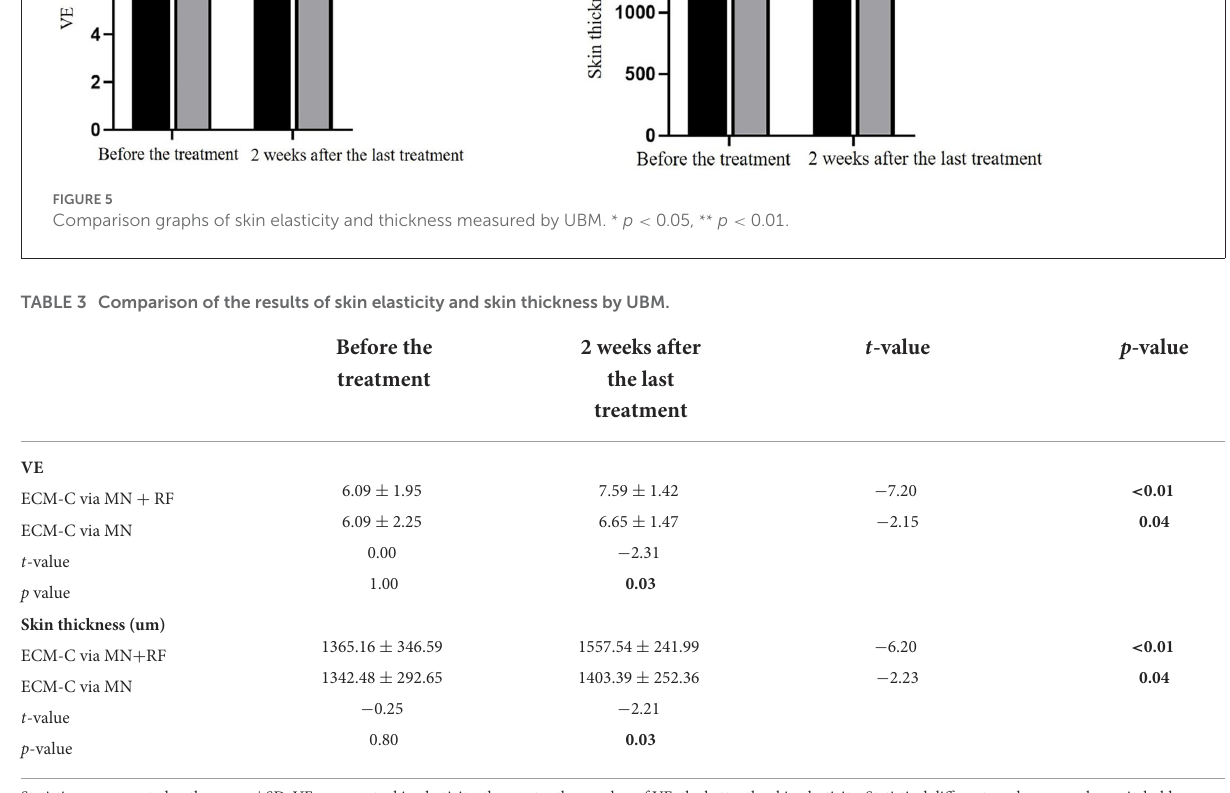
TABLE 3 Comparison of the results of skin elasticity and skin thickness by UBM.